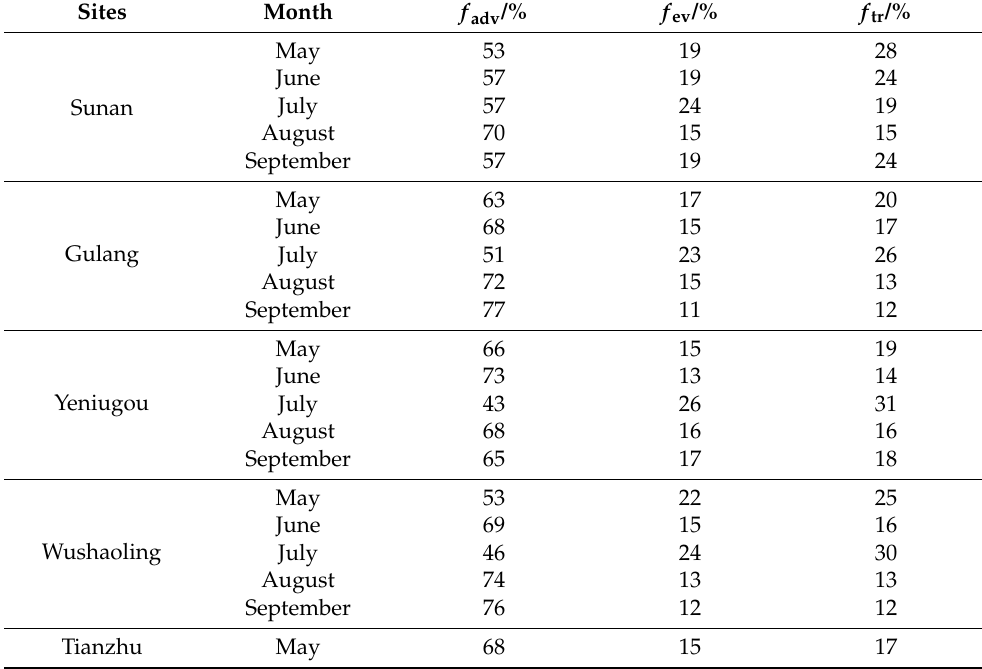
Table 4. Average percent contributions of the three water vapor-to-precipitation sources using